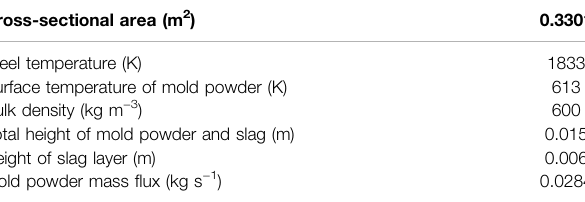
TABLE 2 | Data of a case study for calculation of heating rates (HR).